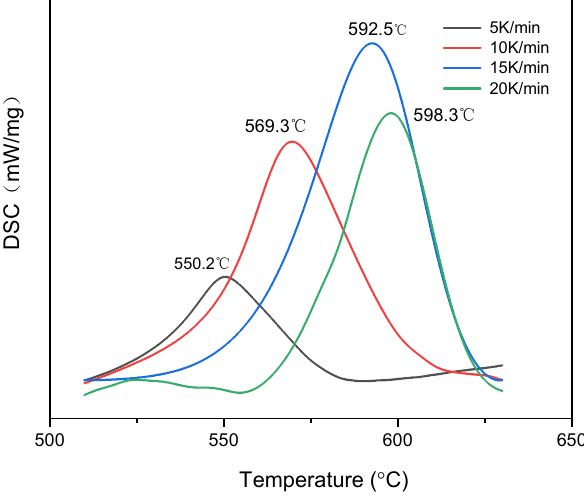
Figure 15. DSC results of Al–CuO/GO at various heating rates. Table 4. The characteristic temperatures and exothermic enthalpy of Al–CuO/GO at various heating rates.